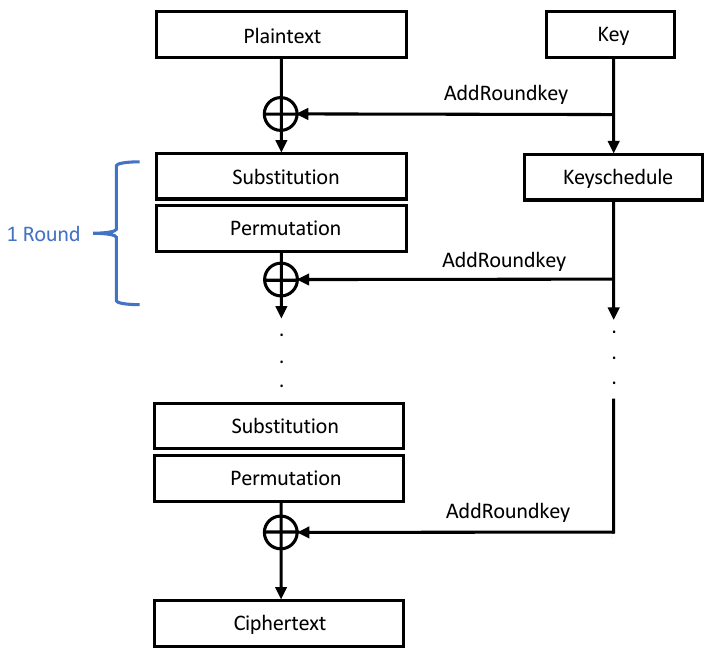
Figure 1. Encryption structure of